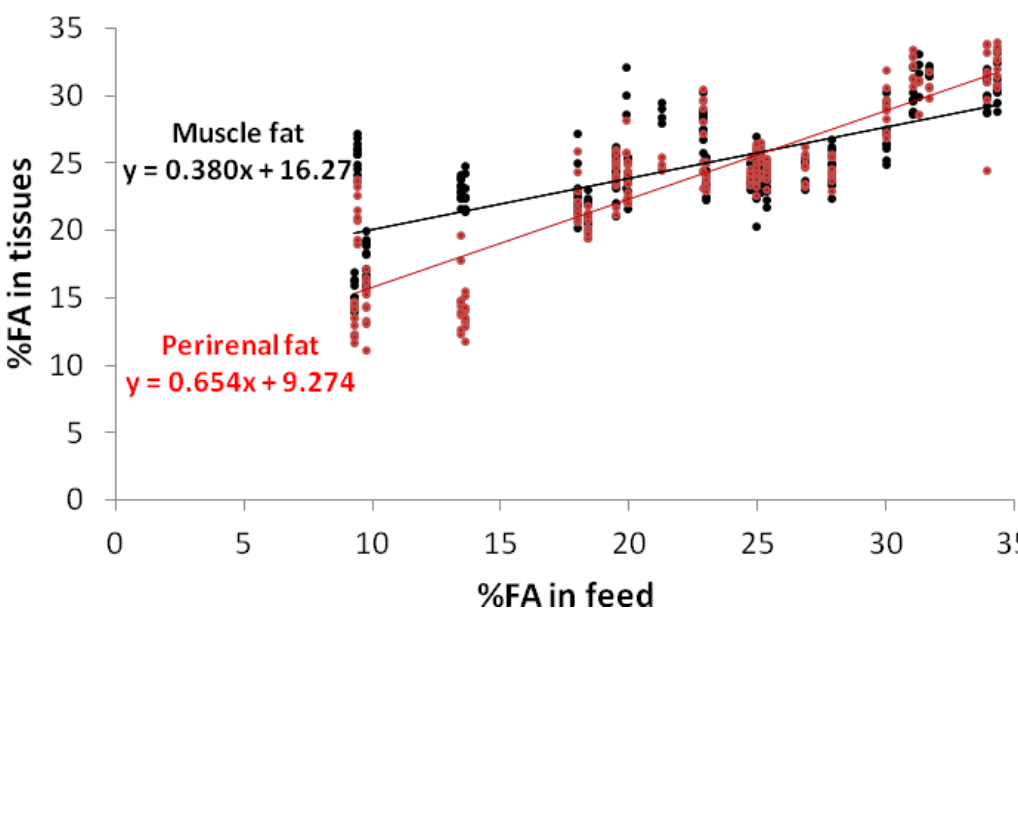
Figure 2. Regressions of the oleic acid (C18:1 n-9) contents in the muscle fat and perirenal fat, according to their contents in the